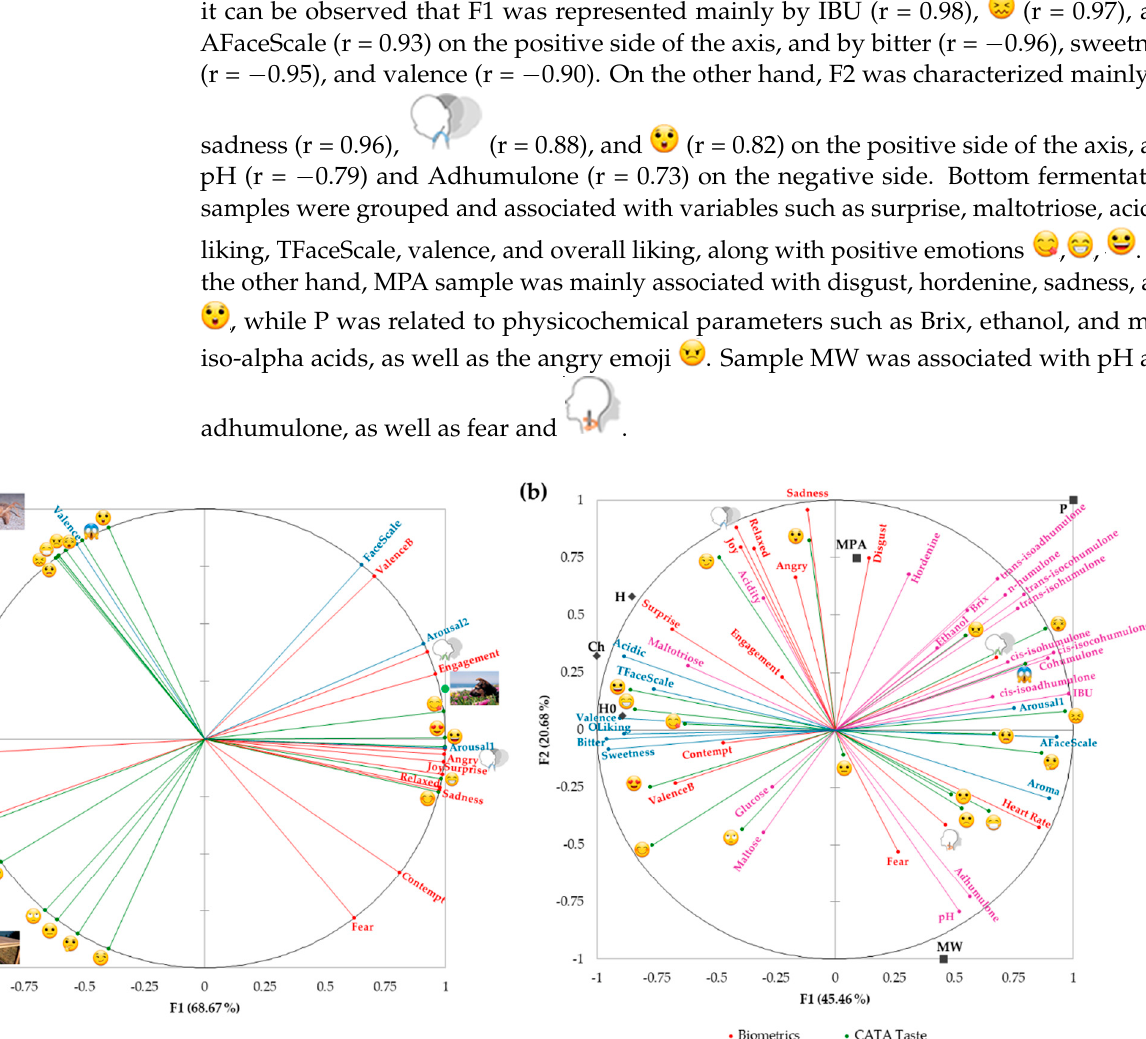
Table 1. Other abbreviations: F1 and F2: factors 1 and 2.